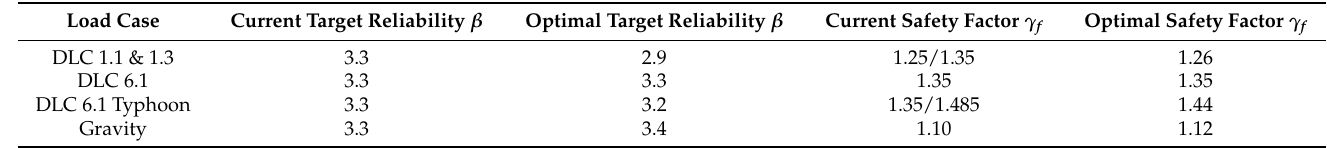
Table 4. Optimal annual target reliabilities and load safety